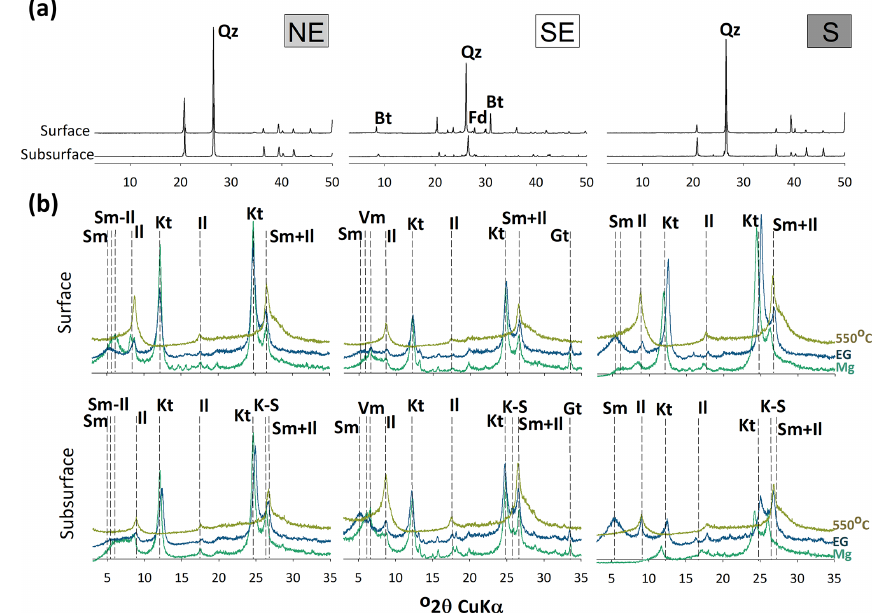
Figure 4. XRD patterns of sand (a) and clay fractions (b) from the seagrass soils of the different studied coastal compartments (northeastern – NE; southeastern – SE; southern – S). Bt: biotite; Fd: feldspar; Il: illite; Kt: kaolinite; K–S: kaolinite–smectite; Qz: quartz; Sm: smectite; Sm-Il: smectite–illite; Vm: vermiculute.